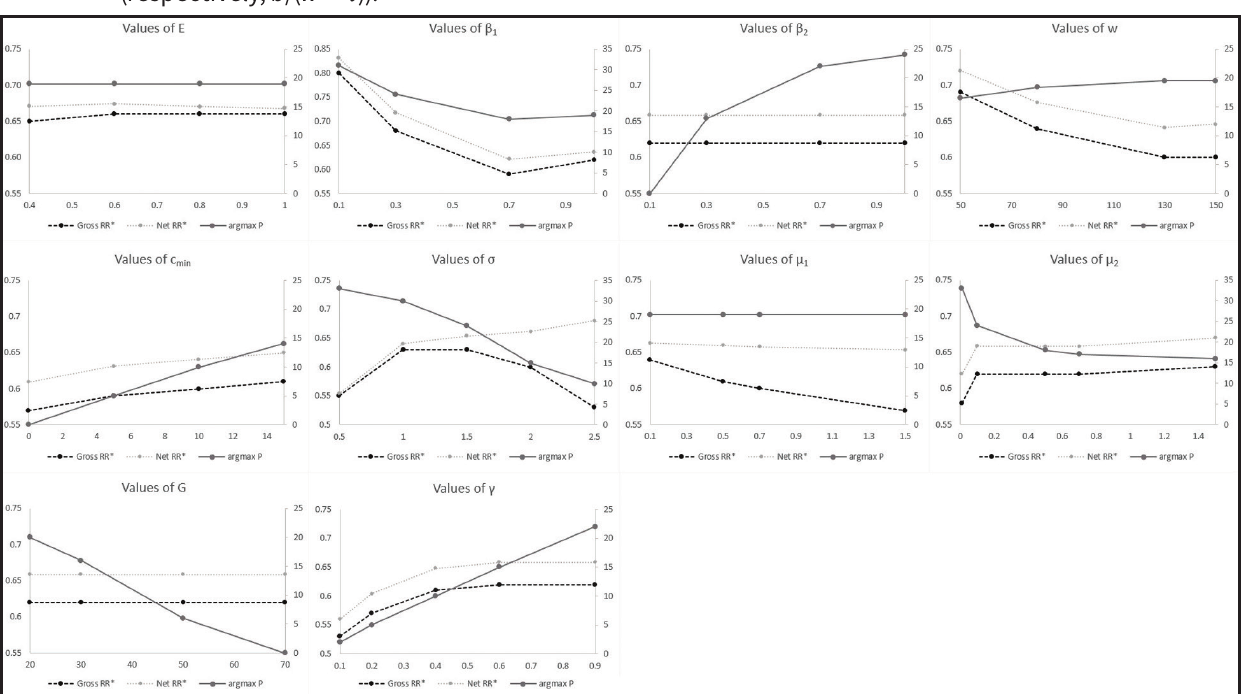
Sensitivity Analysis for the Baseline Model [BM]. These graphs report the results for 43 different specifications, all using the functions of Table 1. We take the parameterization of Table 1 and change one parameter at the time whose values are on the horizontal axis. “argmax P” is the level of b on the right vertical axis for which P ( s , a ) reaches the maximum.“Gross RR*” (respectively, “Net RR*”) gives the corresponding optimal gross (respectively, net) replacement rates on the left vertical axis: b / w (respectively, b /( w - t